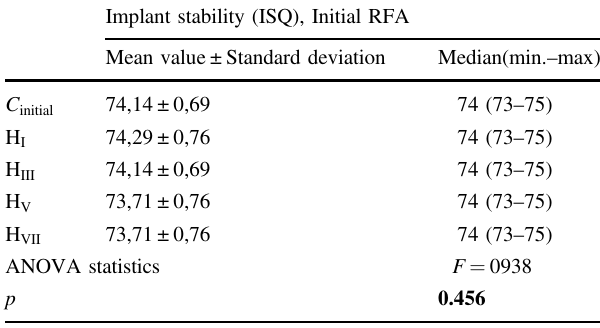
Table 1 Comparison of groups for initial RFA